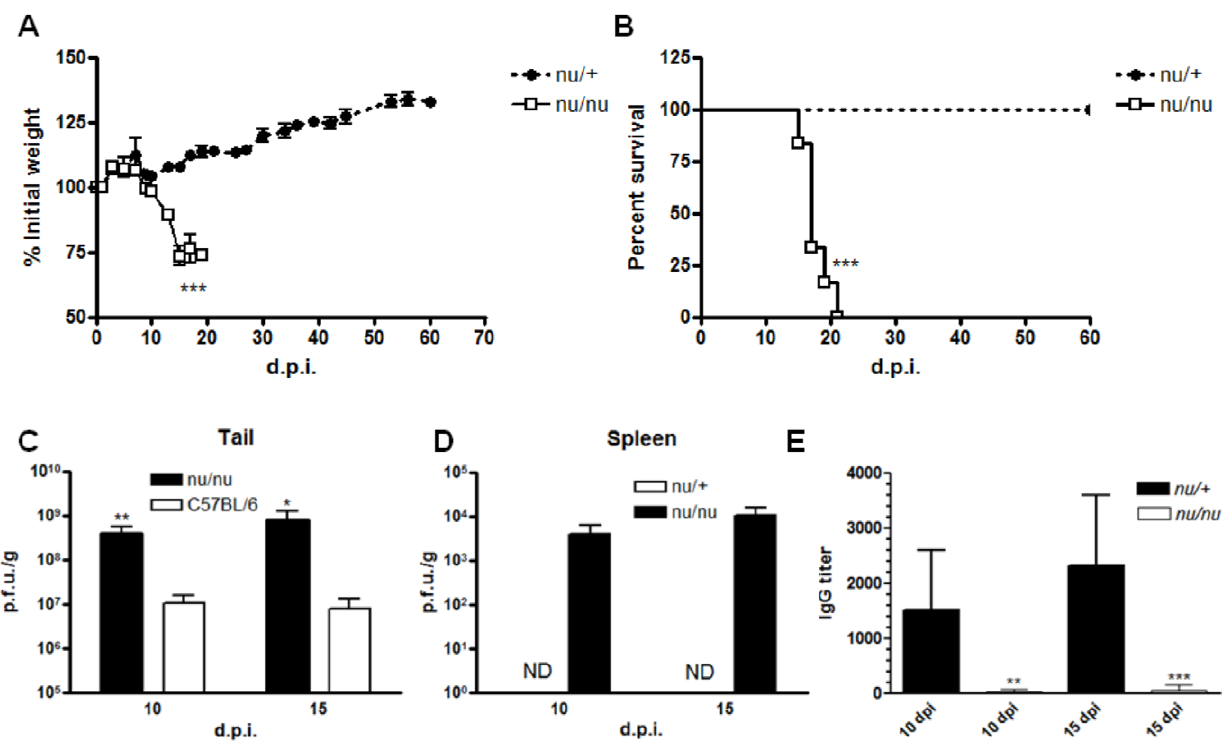
Figure 6. Mice lacking T cells are as susceptible to primary VACV infection as Rag1 2 / 2 mice. NUDE athymic mice ( nu/nu ) and their wild type littermates ( nu/ + ) were infected with 10 7 p.f.u. of VACV-WR by tail scarification. ( A ) Weight curve of NUDE mice (*** p , 0.001, unpaired t test). ( B ) Survival curve of nu/nu and nu/ + after infection (*** p , 0.001, log-rank test). ( C ) Viral titers were determined in tail of C57BL/6 and nu/nu mice (** p , 0.01 day 10 p.i. and * p , 0.05, t test). Data of viral titer in tails of nu/ + mice are missing. ( D ) Spleens of nu/nu and nu/ + mice were removed at the times indicated and virus titer was determined in BSC-40 cells. ( E ) VACV-specific IgG antibodies were determined by ELISA in serum of nu/nu and nu/ + mice (**p , 0.01 and ***p , 0.001, t test). Bars represent the mean and standard error (SEM), except for 6E, where bars represent mean and standard deviation (SD). The results shown are representative of two experiments. ND: not detected.